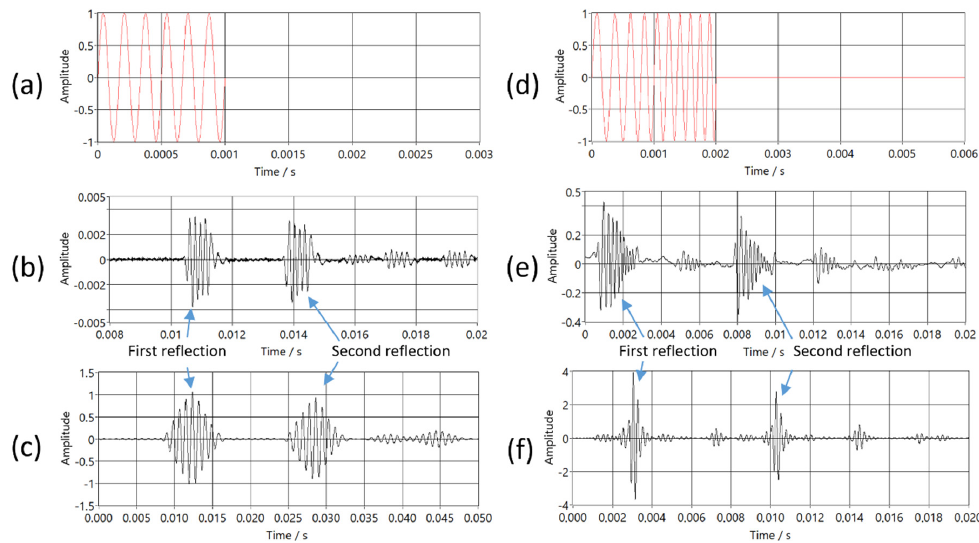
Figure 12. Result of the cross correlation between the transmitted and received signals for gated sinewave and chirp: ( a ) excitation signal for gated sine wave; ( b ) received signal from gated sine wave excitation; ( c ) result of cross-correlation for gated sine wave; ( d ) excitation signal for chirp signal; ( e ) received signal from chirp excitation; ( f ) result of cross-correlation for chirp.